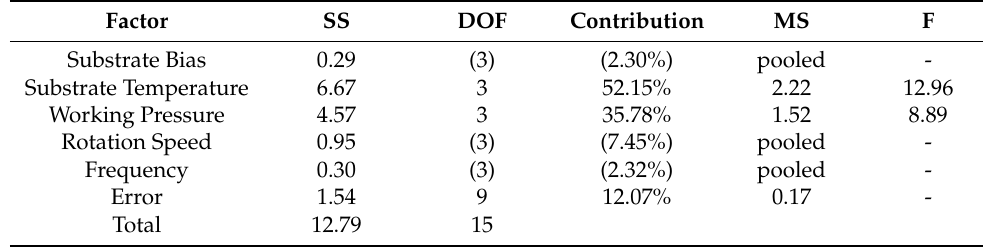
Table 6. ANOVA analysis results for film hardness. () indicates non-dominant factor. Factor Substrate Bias Substrate